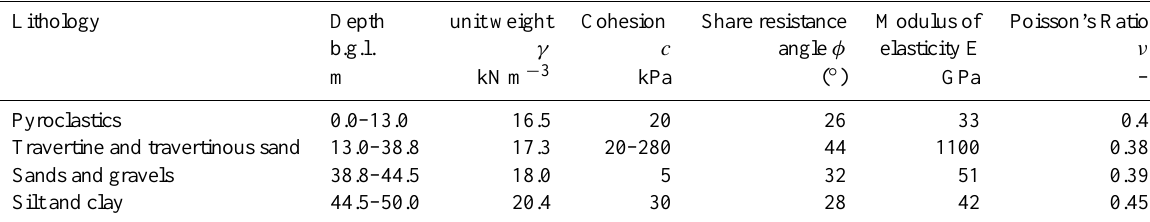
Table 4. Physical and mechanical properties of materials.